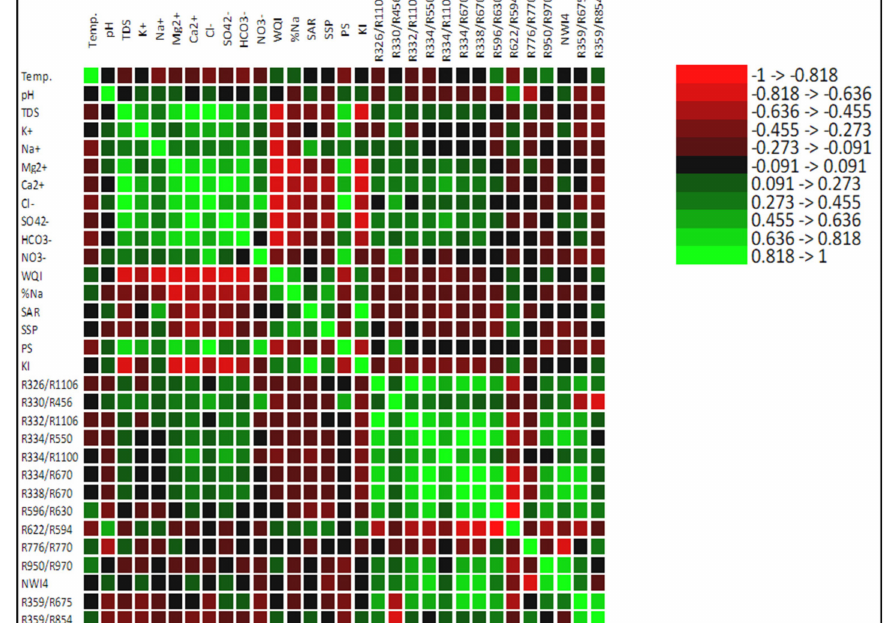
Figure 6. Correlation matrix of spectral reflectance indices with physicochemical parameters and irrigation water quality indicators: irrigation water quality (IWQ), percent sodium (%Na), sodium absorption ratio (SAR), soluble sodium percentage (SSP), potential salinity (PS), and Kelly’s index (KI) in the Central Nile Delta ( n =